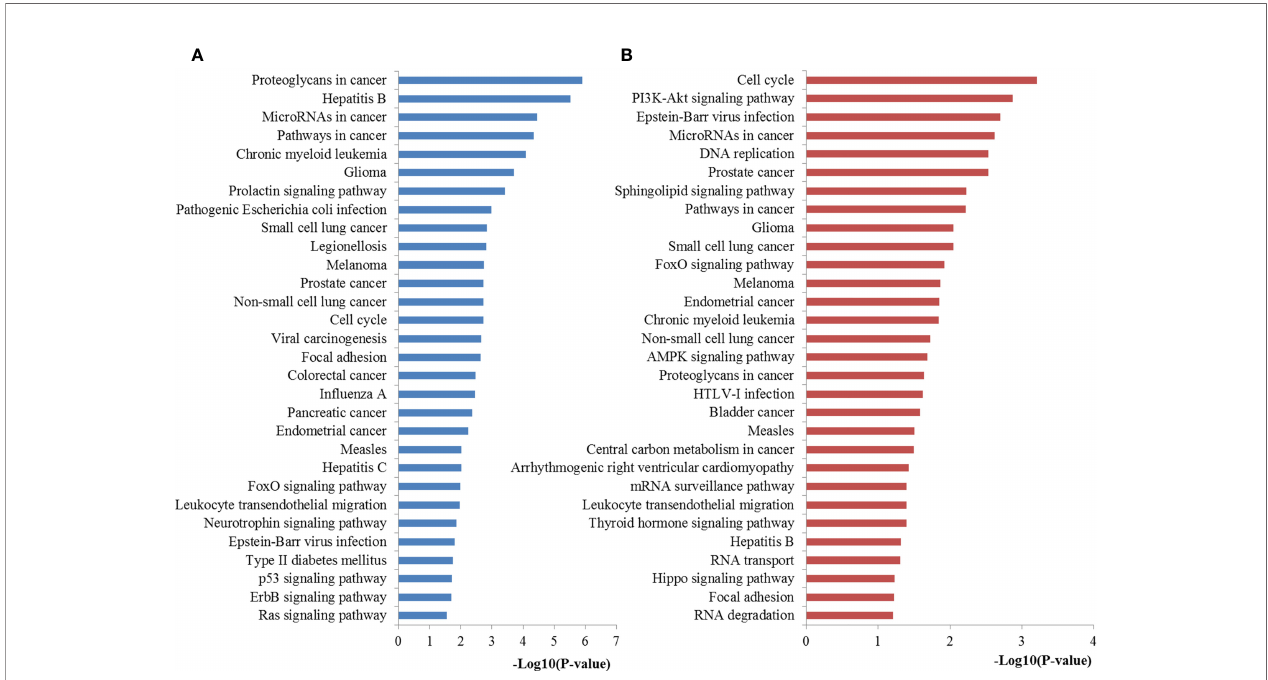
FIGURE 7 | Pathway enrichment results for miR-221/222 target genes. (A) Pathways enriched by target genes of miR-221; (B) Pathways enriched by target genes of